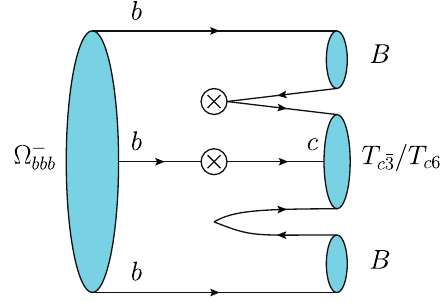
decays into two B -mesons and a bbb